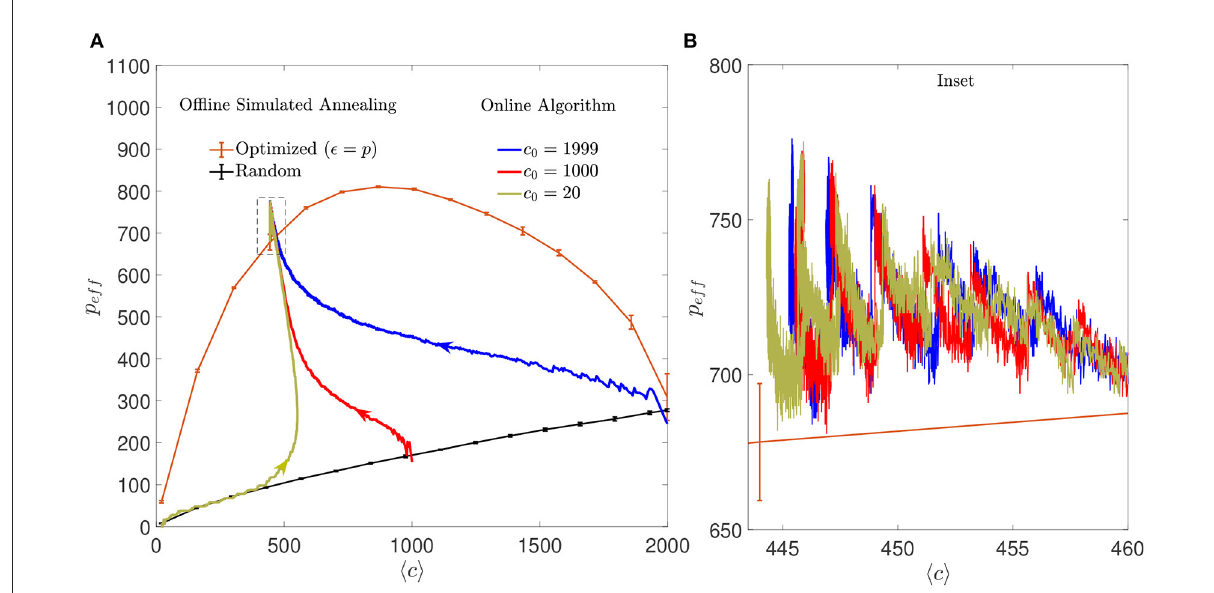
FIGURE11 Regimes dominated by addition or pruning of connections lead to a performance similar to the one corresponding to offline optimized connectivity. (A) Evolution of the learning process of the online algorithm in the space of effective maximum number of patterns vs. mean connectivity for different initial conditions: highly diluted (dark yellow), intermediate (red), or fully connected (blue) (a single simulation for each initial condition is shown). Arrows indicate the direction in which the networks evolved from the corresponding initial conditions. For comparison, the distribution of maximum p eff that offline optimized (orange) or random (black) networks can achieve with similar criteria is also shown (mean ± s.d., computed over five simulations each). Note that the final network optimized by the online algorithm performs slightly better, possibly because the number of connections is not fixed across neurons. Dashed box corresponds to inset shown in (B) . All networks have N = 2,000. (B) Inset of (A) showing in detail the last iterations of the online algorithm for the three different initial conditions. Every time a set of 10 patterns is loaded to the network, the effective storage capacity drops abruptly. Within the following iterations, p eff increases until 90 % of patterns are retrieved or the simulation